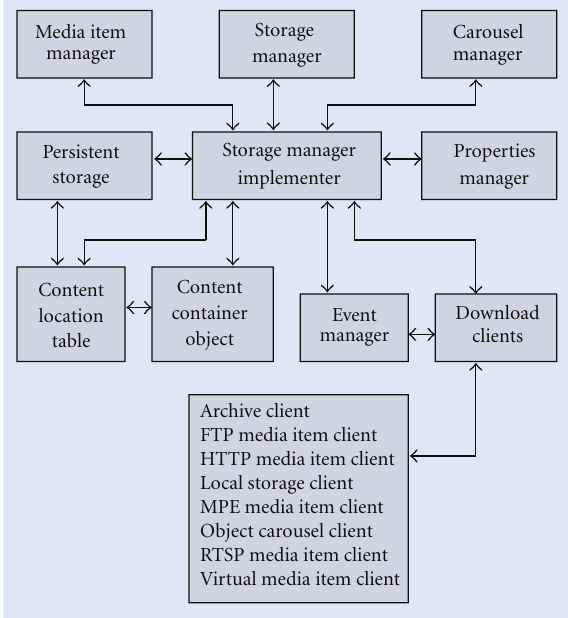
Figure 3: The distributed storage manager system